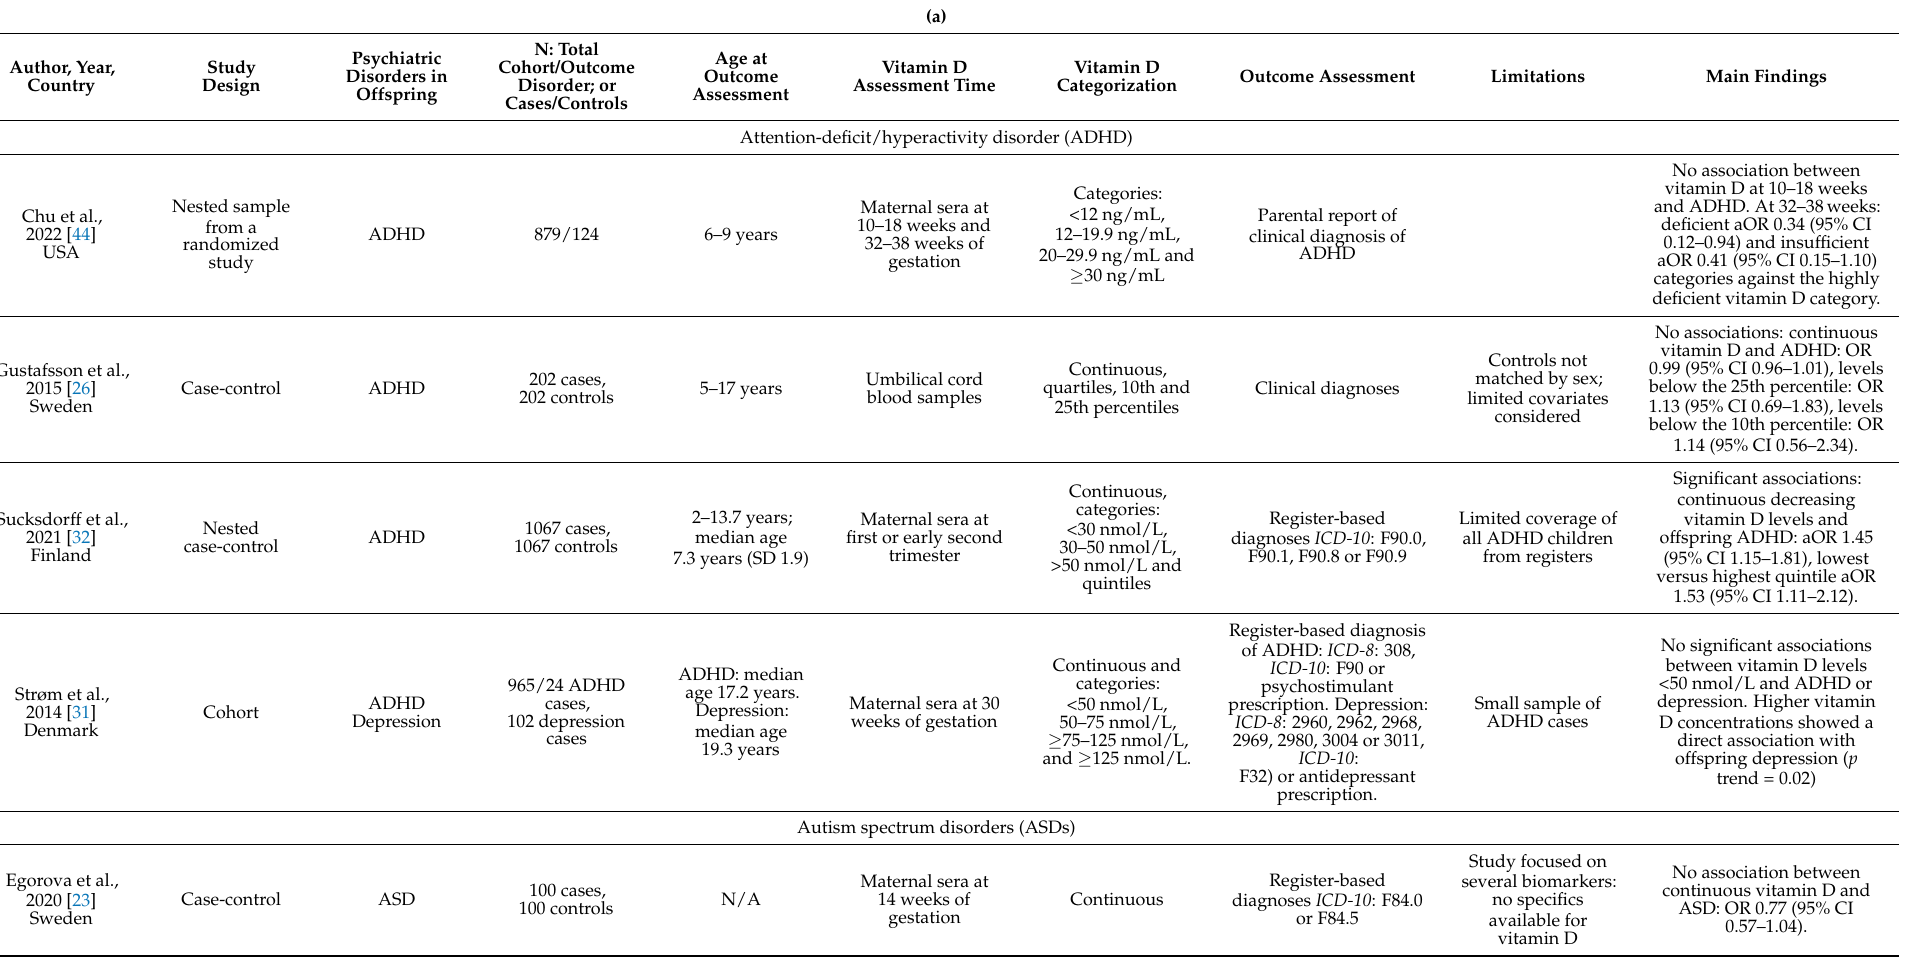
Table 1. ( a ) Summary of papers with psychiatric disorders or diagnoses as the outcome. ( b ) Summary of papers with psychiatric symptoms or questionnaire scores as the